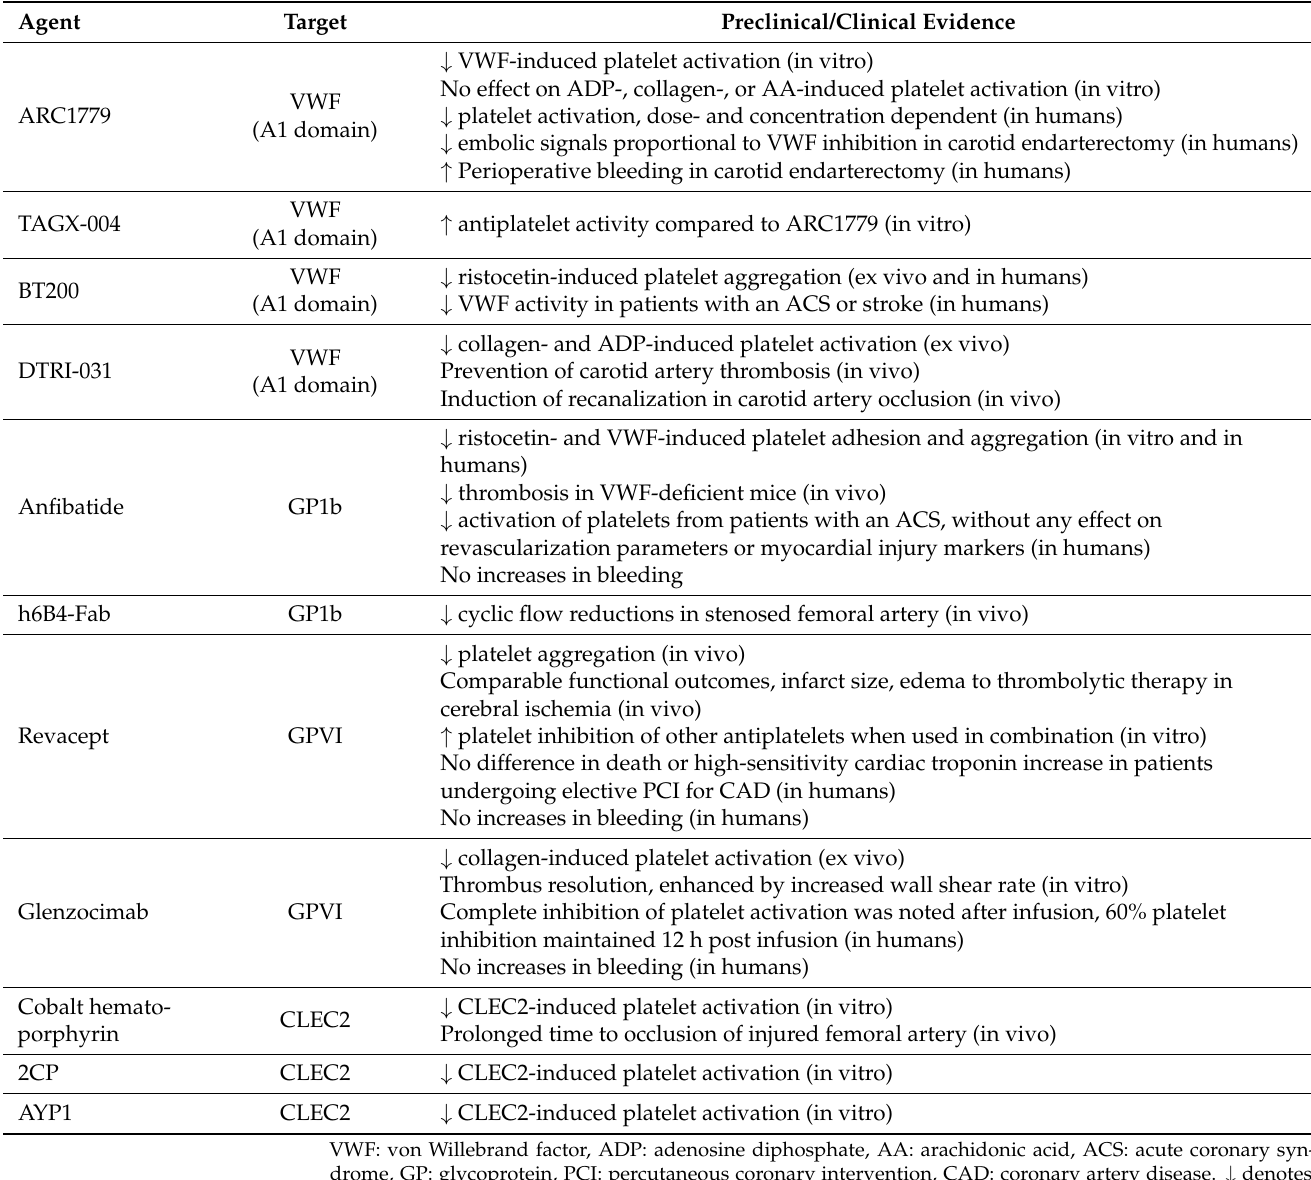
Table 2. Summary of the effects of investigational antiplatelet